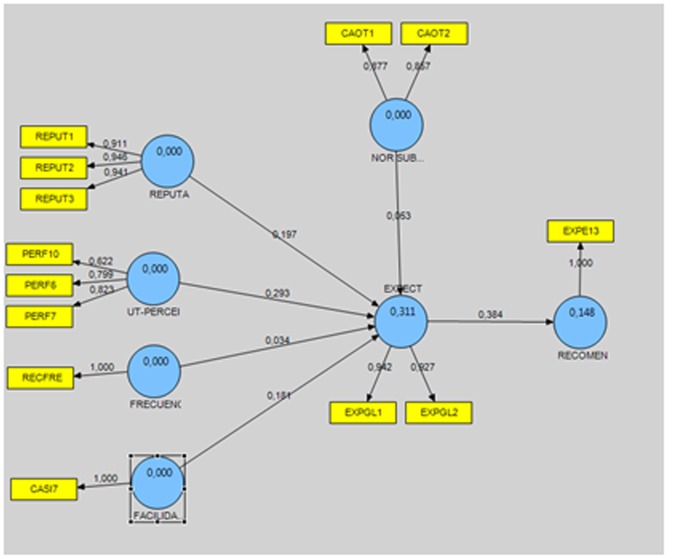
Structural model.